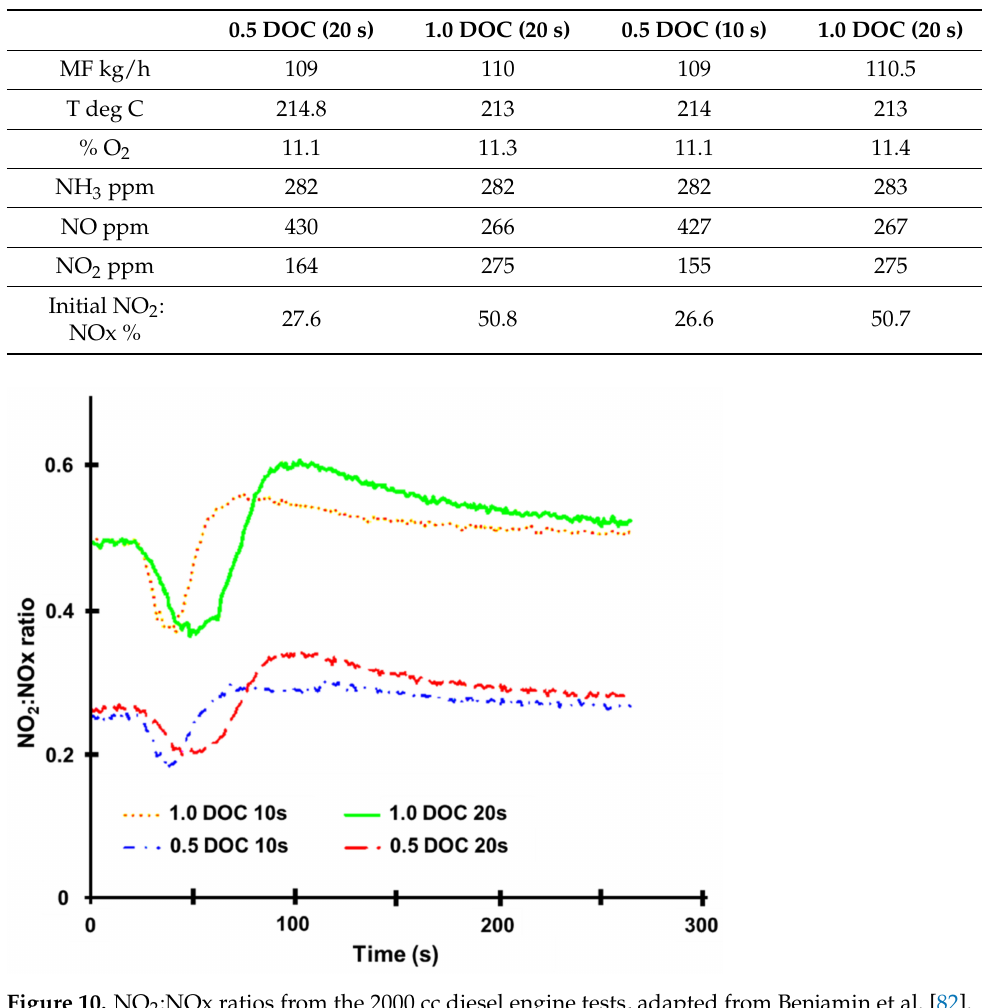
Table 1. Summary transient test conditions for 10 s and 20 s adapted from Benjamin et al. [82].